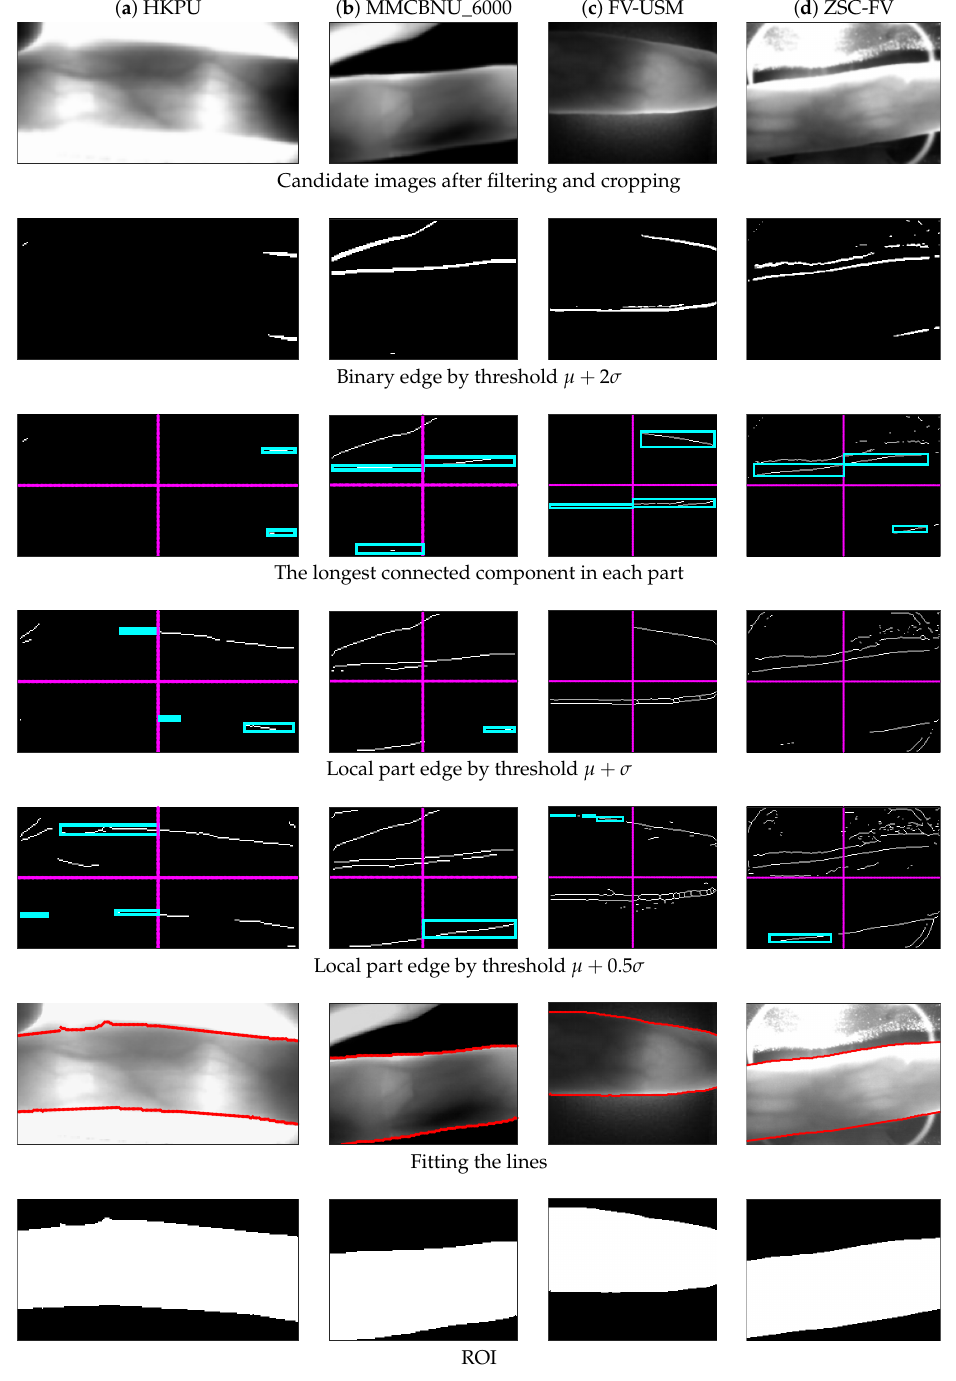
Figure 8. Processing results of some poor-quality images from the four datasets, respectively. ( a ) HKPU, ( b ) MMCBNU_6000, ( c ) FV-USM, and ( d )